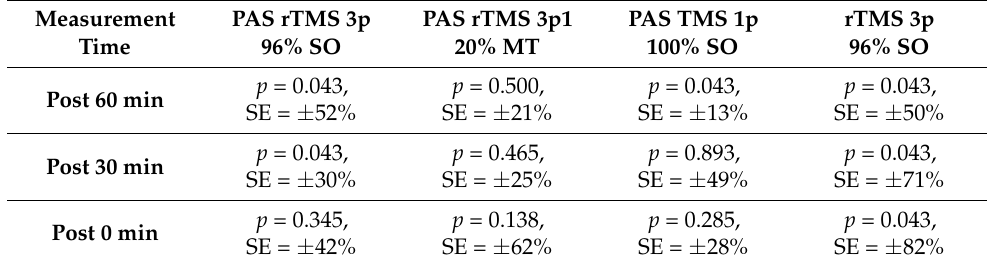
Figure 3. The median values of MEP potentiations among the subjects ( n = 5) produced by four tested protocols at three post-stimulation measurement points. The bars with * sign represent the statistically significant outcomes (see Table 2). Comparing the median is more relevant in this study because the data are skewed and not normally distributed, as depicted in Figure 2. Table 2. The p -values and standard error of 4 protocols at three measurement points from Wilcoxon test.